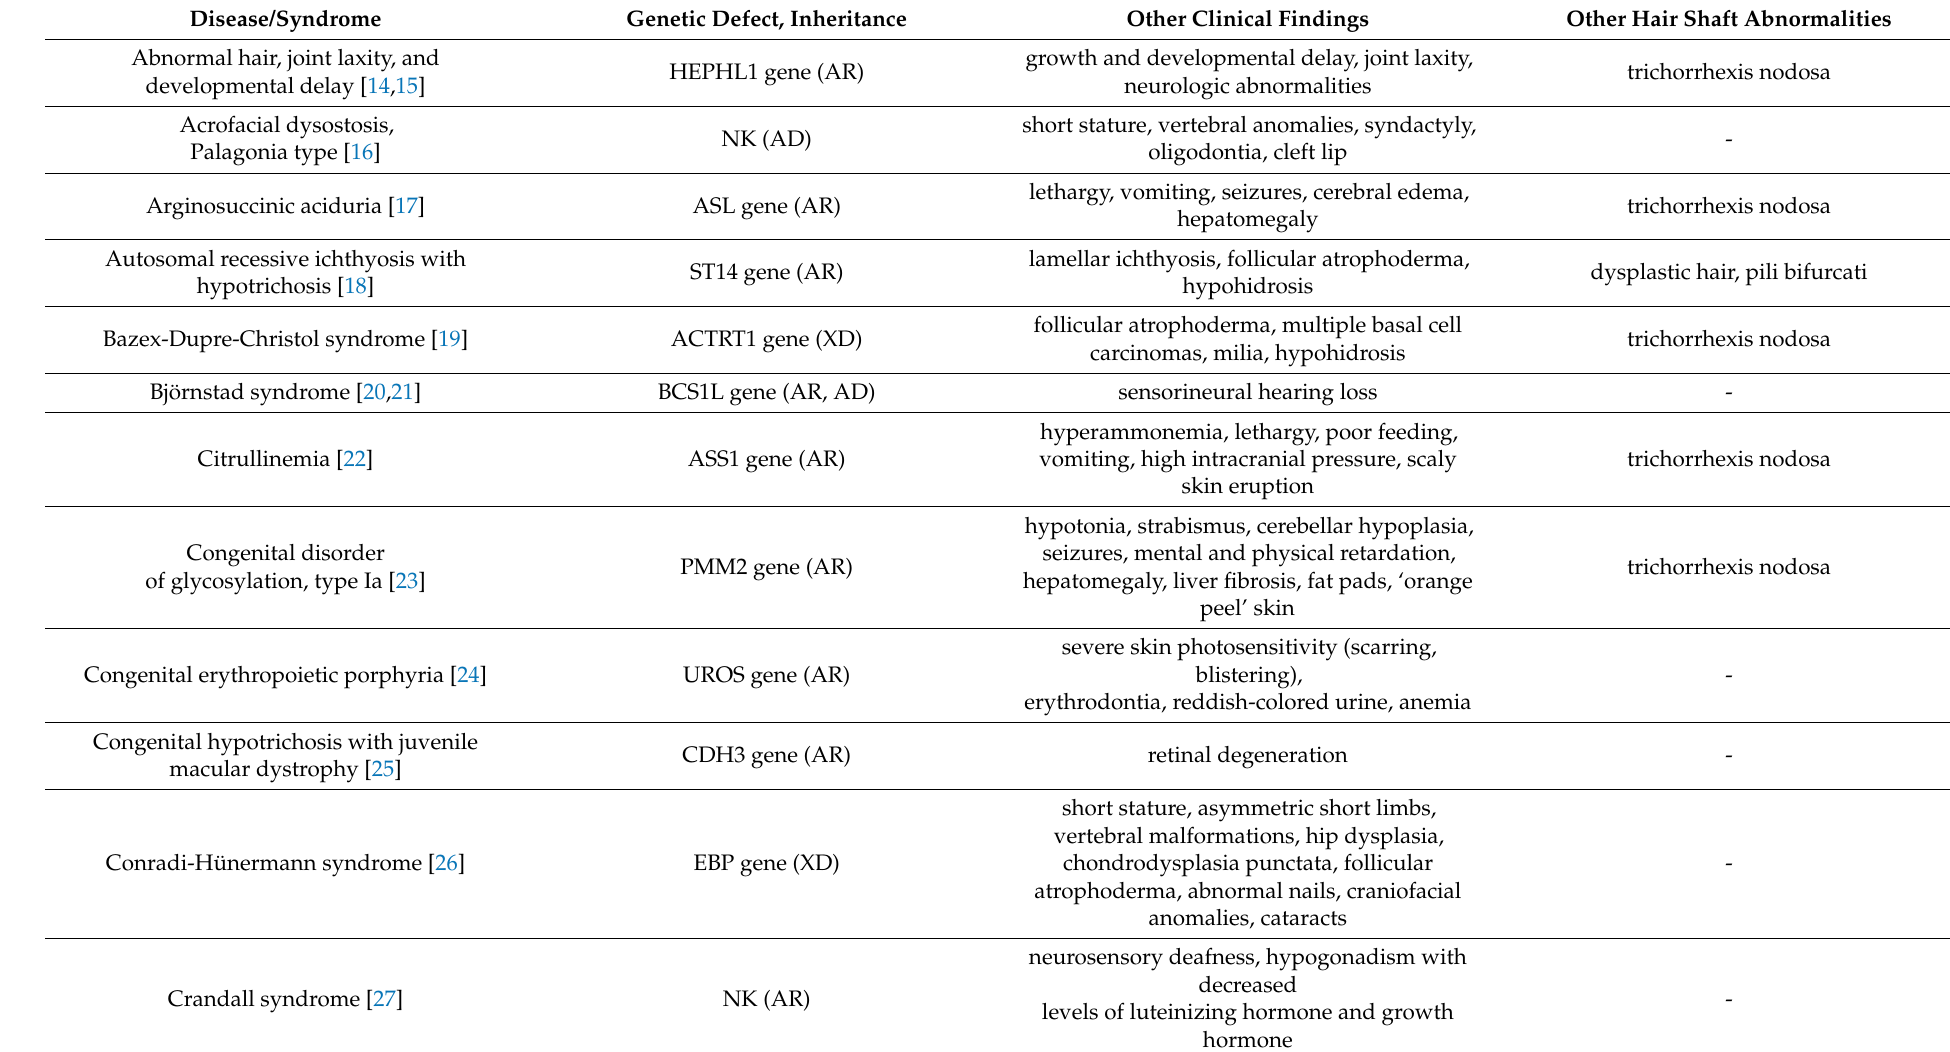
Table 1. Pili torti in genetic diseases and